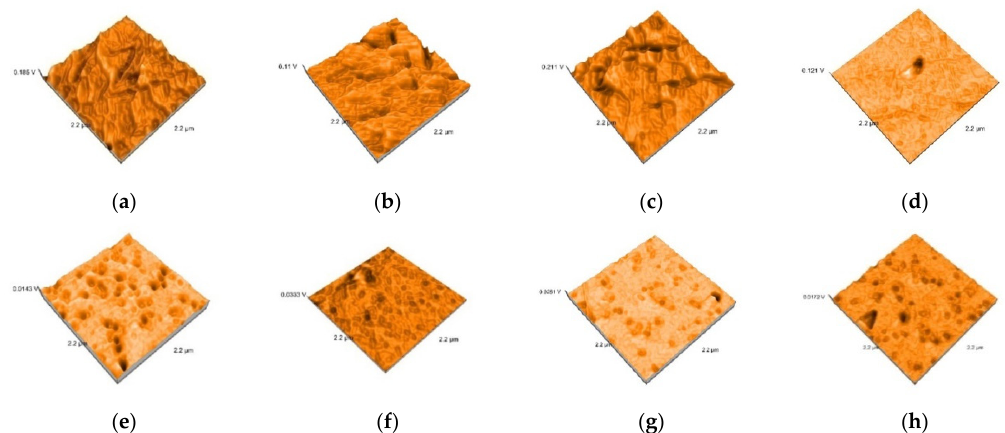
Figure 4. 3D images of Lava specimens: ( a ) Lava Ultimate–tribochemical silica airborne particle abrasion, ( b ) Lava Ultimate sandblasted, ( c ) Lava Ultimate etched, ( d ) Lava Ultimate polished, ( e ) Lava Ultimate airborne particle abrasion and glazed, ( f ) Lava Ultimate sandblasted and glazed ( g ) Lava Ultimate etched glazed, ( h ) Lava Ultimate polished glazed.